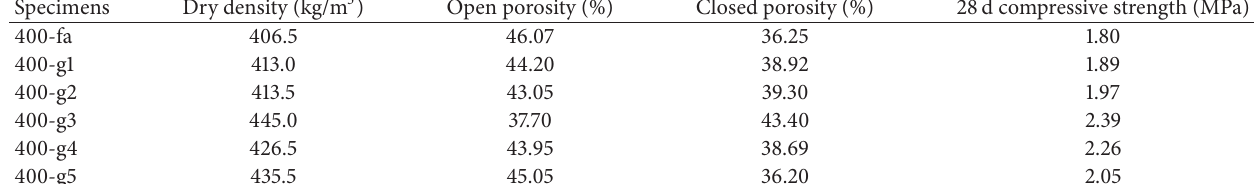
Table 4: The correlation between porosity and compressive strength of the test specimens.